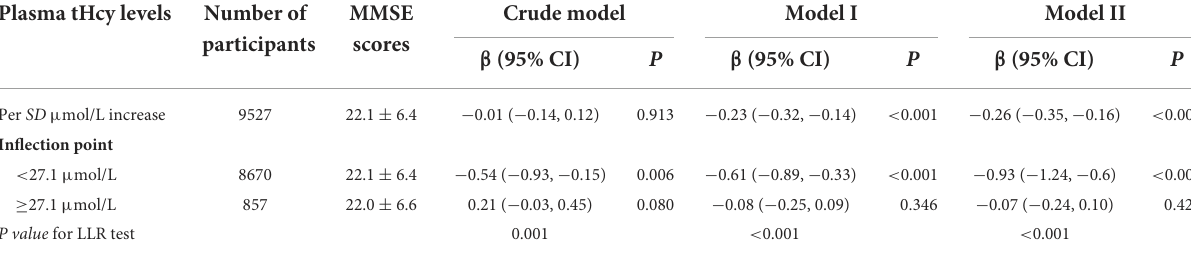
TABLE 2 Threshold effect analysis of plasma tHcy levels on MMSE scores using piece-wise binary linear regression models.